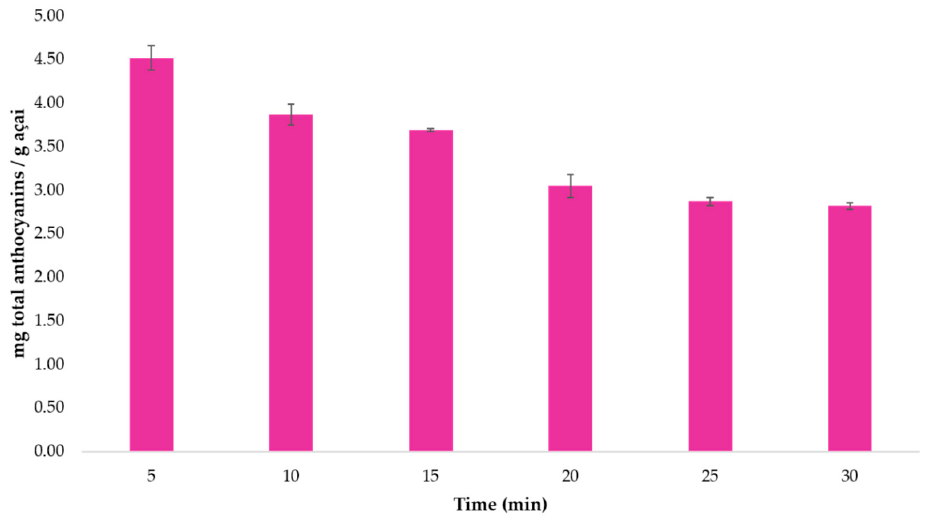
Table 2. Optimum conditions for TA and TPC by UAE.